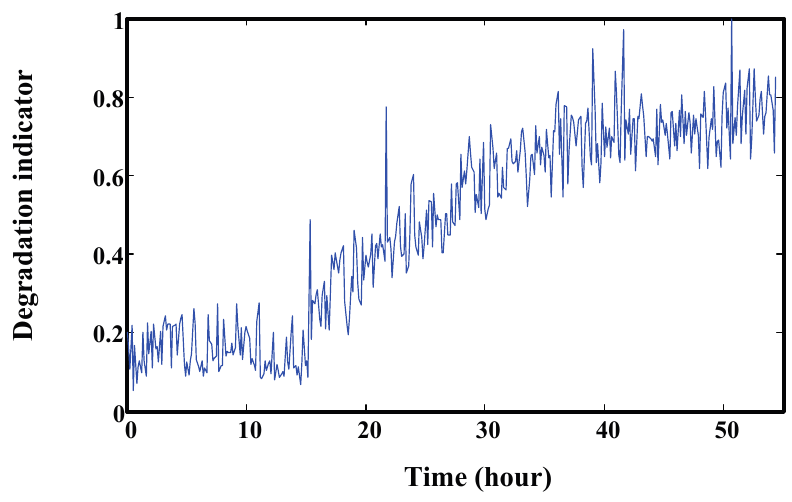
Figure 20. Helicopter normalized degradation indicator of the left shaft of the generator. Trend prediction results of the helicopter generator at four time points are illustrated in Figure 21. It shows that the predicted values are overlapped with the real values. This demonstrates the good prediction effect of the proposed method. The RUL prediction result at each inspection time is given in Figure 22. We can see that the variances of predicted RUL are gradually decreasing. Compared to the gearbox RUL prediction, it is more effective for the helicopter degradation prediction. In order to acquire more data, we interpolated values into this degradation trajectory. This does not change the original trend. For this test, initial window size is selected as 100. The minimum window size is 20.